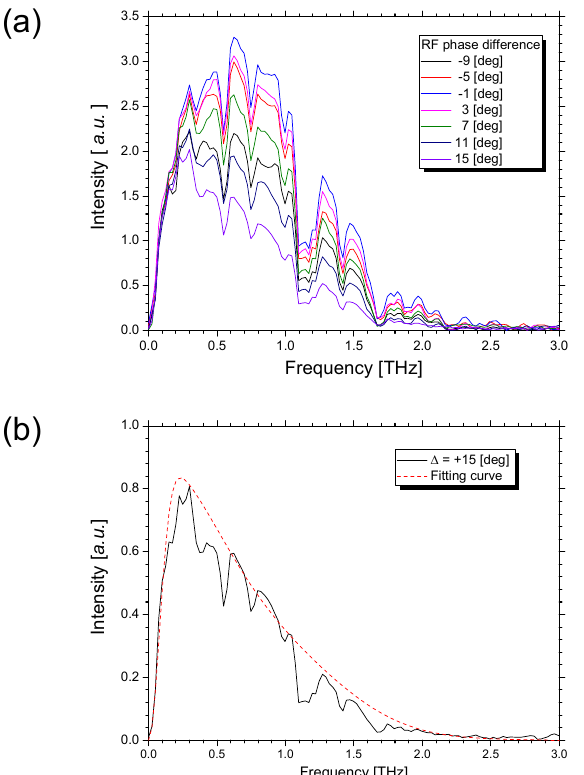
Figure 3. ( a ) Relationship between the RF phase difference and measured CER spectrum. ( b ) Fitting curve (red dotted curve) applying the least squares approximation to the measured CER spectrum (black solid curve) for ∆ = +15°.